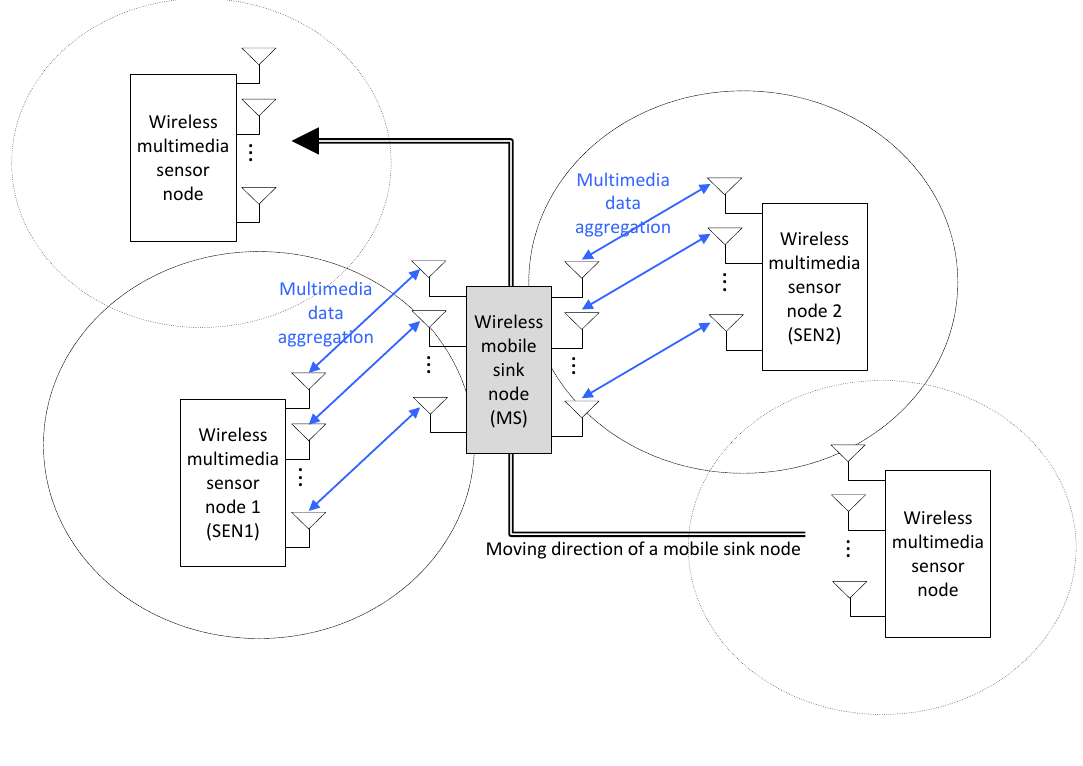
Figure 1. Mobile wireless multimedia sensor networks (WMSNs) with multi-node (MN) multiple input and multiple output